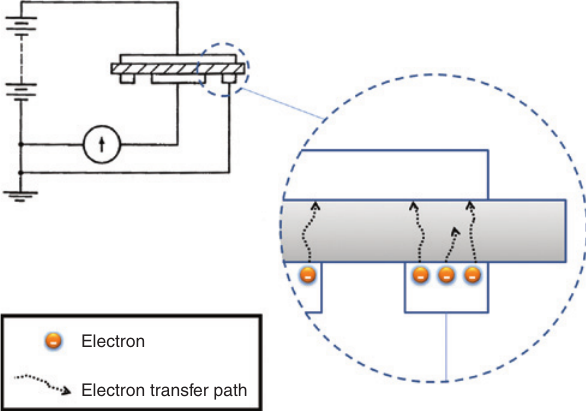
Figure 9 Electron transfer through neat PC specimen during volume resistivity test.